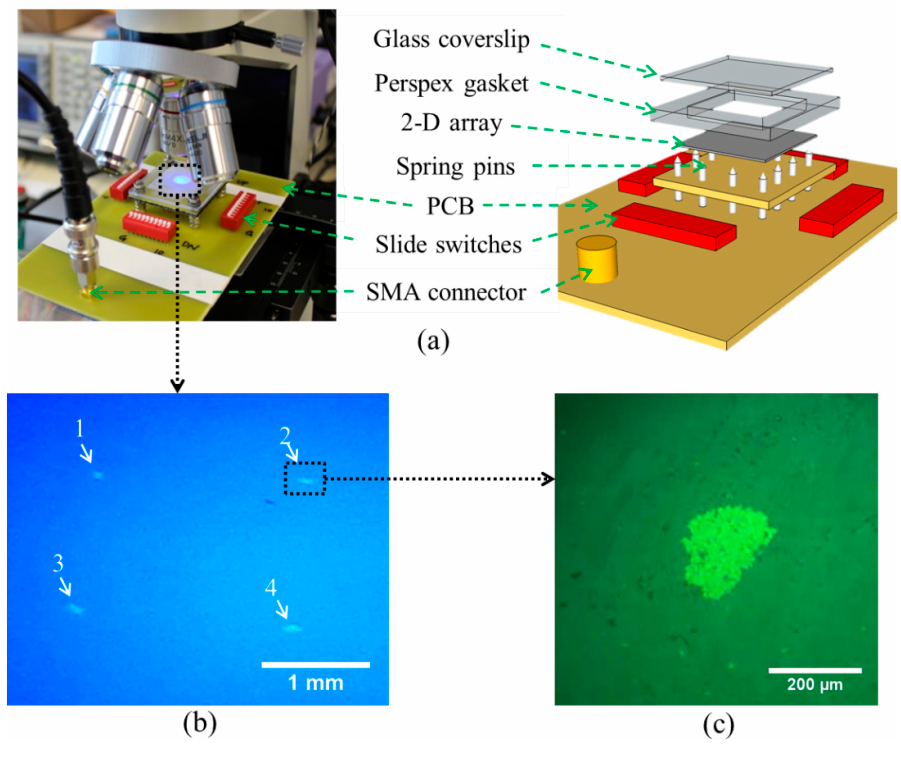
Figure 24. Trapping with four elements: ( a ) experimental set-up and schematic diagram of device; ( b ) photograph of four trapped agglomerates; and ( c ) microscope image of a trapped